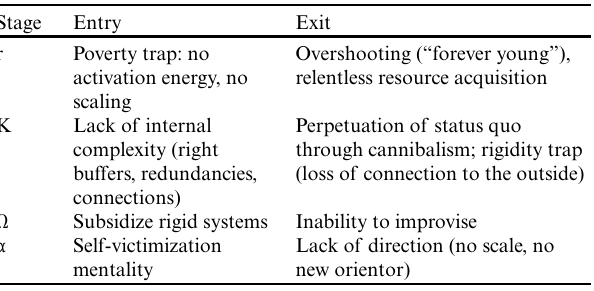
Table 2. Key entry and exit points for each stage of the adaptive